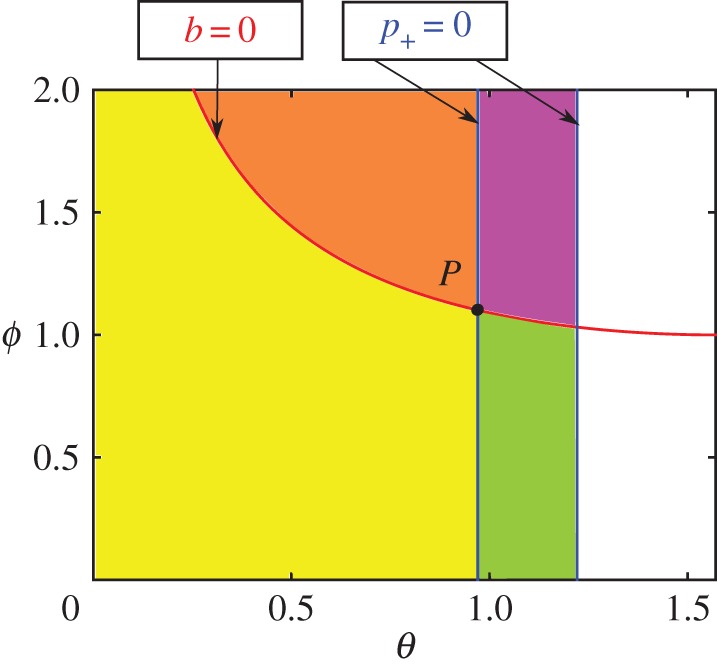
The (θ,ϕ)-plane for the classical Painlevé problem of figure 1, for α=3 and μ=1.4. The point P has coordinates (θ1,csc θ1), where θ1 is given in (2.14). In the first quadrant centred on P, we have b>0, p+<0, so the dynamics is indeterminate (non-unique). In the second quadrant, b>0, p+>0 and the rod lifts off the rough surface. In the third quadrant, b<0, p+>0 and the rod moves (slips) along the surface. Here, Génot & Brogliato [17] showed that the dynamics cannot cross p+=0 unless also b=0. In the fourth quadrant, b<0, p+<0 and the dynamics is inconsistent (non-existent). Even though the constraint y=0 is satisfied, there exists no positive value of FN, contradicting (2.11).